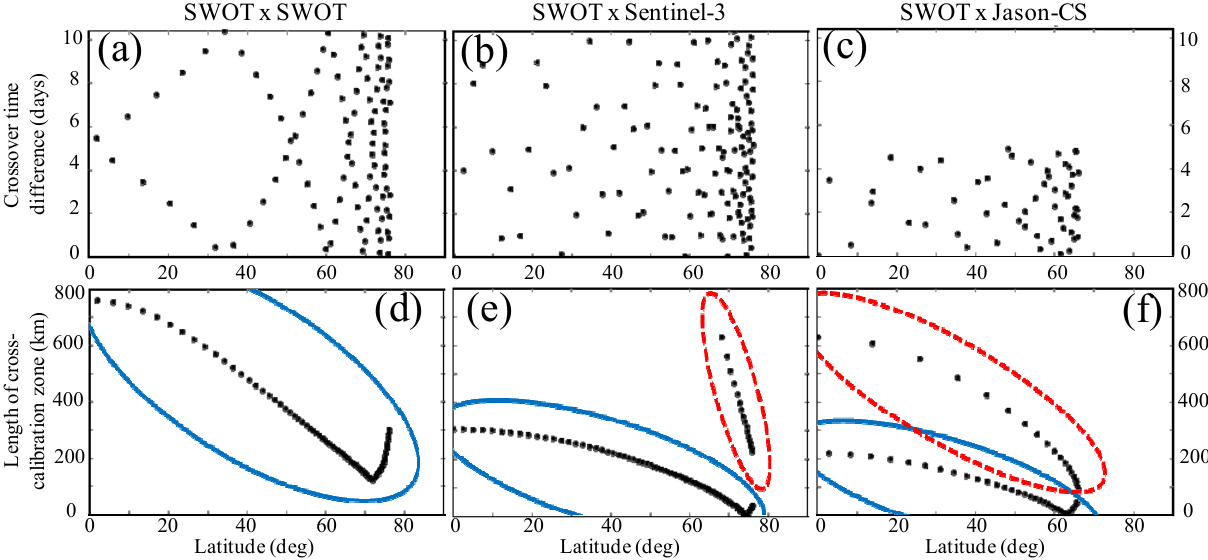
Figure 16. Overview of the crossover distribution for SWOT’s 10-day orbit. ( a – c ) show the crossover delta-time (time difference between co-located pixels in days) and ( d – f ) show the along-track length of the SWOT segment that is in the calibration zone (unit: km). The blue ellipses (plain) highlight crossovers between ascending/descending arcs and the red ellipses (dashed) highlight crossovers between ascending/ascending or descending/descending